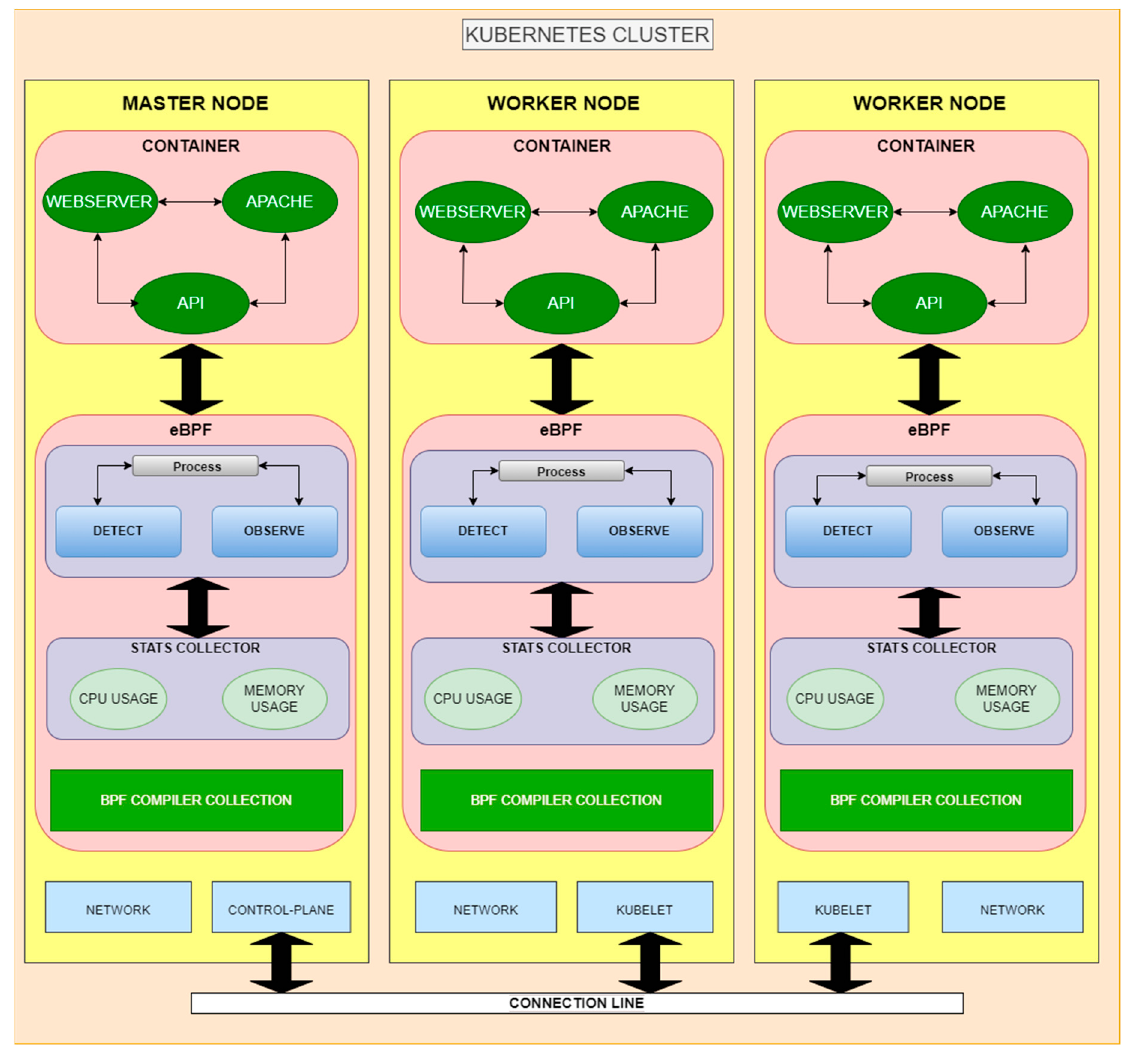
Figure 1. Schematic block diagram of the proposed solution.